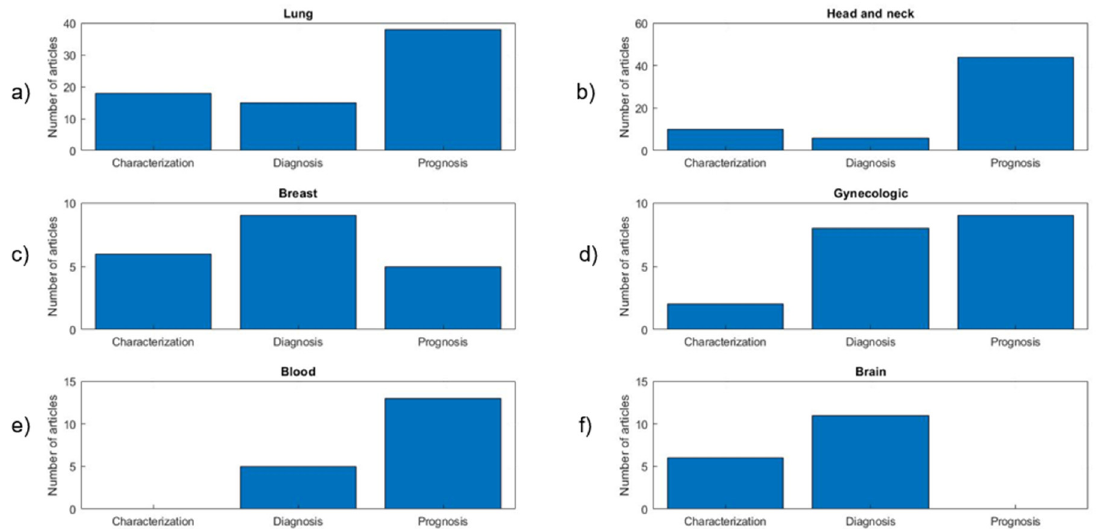
Figure 4. The number of articles associated with each cancer type group. ( a ) Number of patients per number of groups studied in the present review. ( b ) Distribution of cancer types in the “Other” group. In green, the percentage of publications corresponding to that group. * Percent- ages in panel ( b ) represent the percentage in the “Other” group.